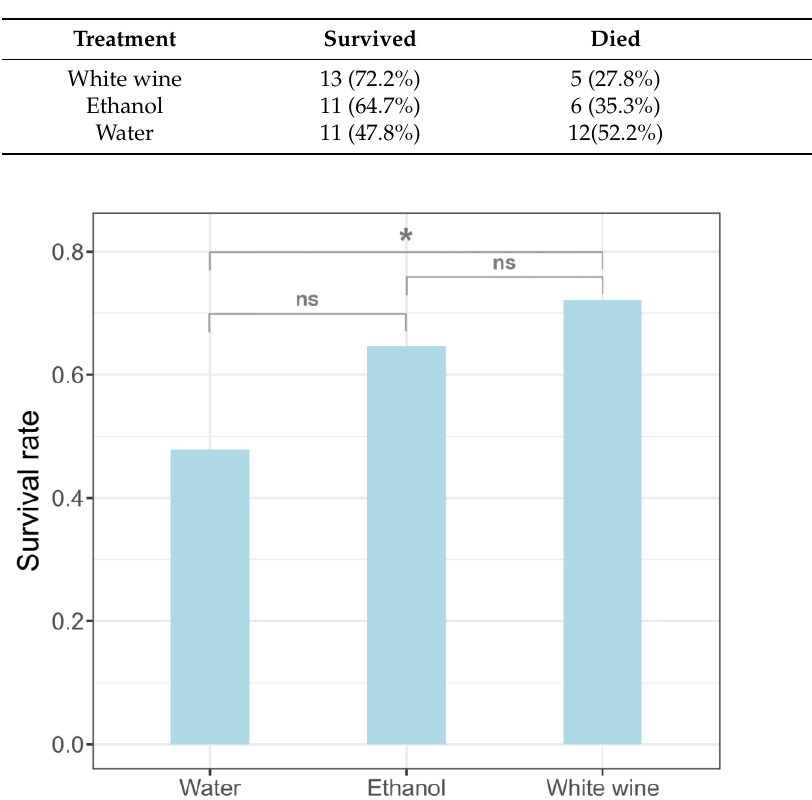
Table 1. Number of rats per drinking group with corresponding survival rates 4 days after myocardial infarction.